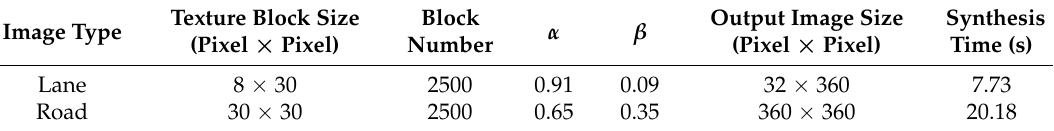
Table 1. The parameters used for improved Image Quilting to synthesize images.